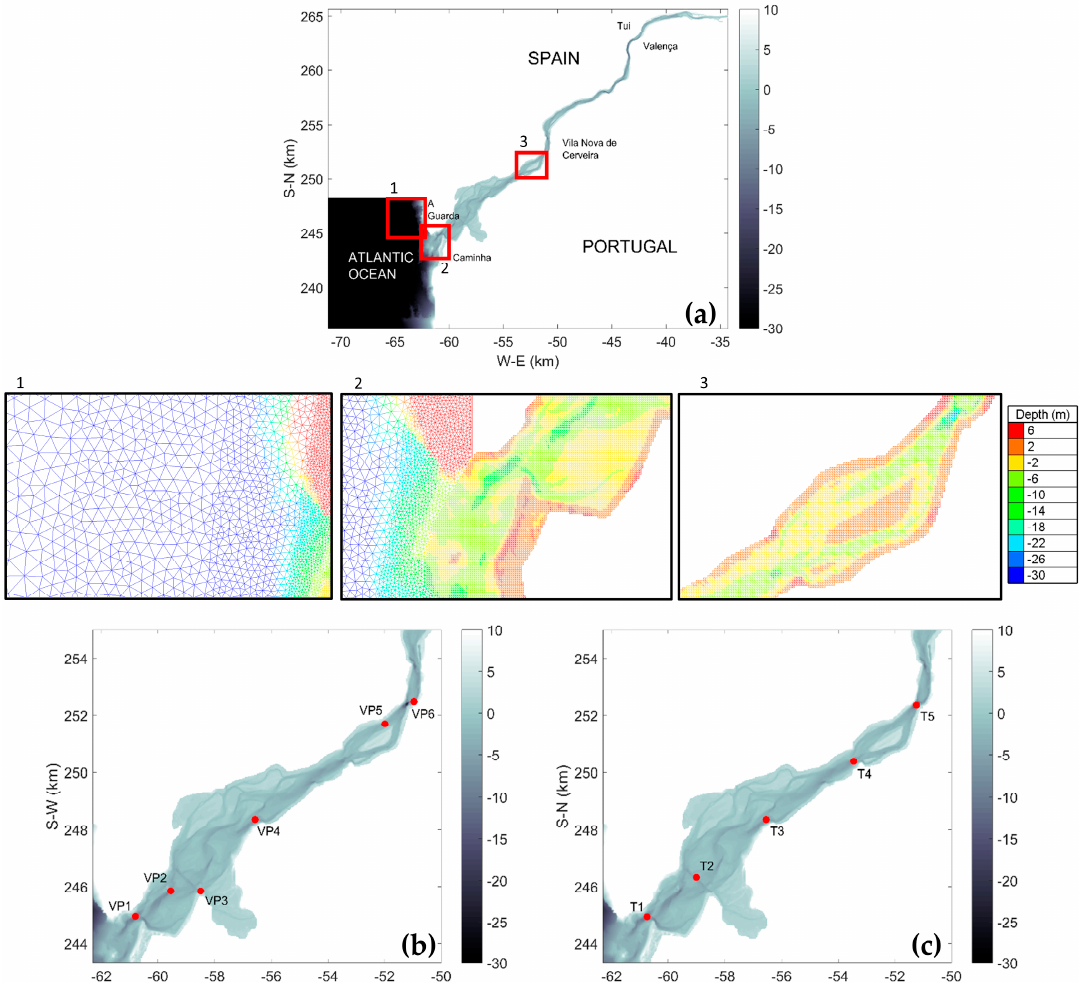
Figure 1. Computational domain and control stations. Horizontal coordinates in datum PT-TM06/ETRS89. ( a ) Computational domain, grid close–up figures and bathymetry (in metres referred to the MSL—mean sea level); ( b ) calibration and validation stations; and ( c ) numerical tidal gauges.